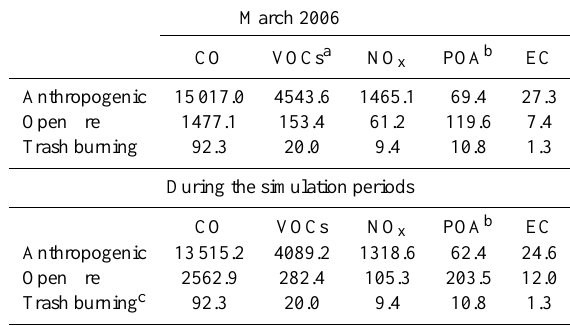
Table 2. Emission averages (tons/day) from different sources in the model domain during MILAGRO in March and during the simula- tion